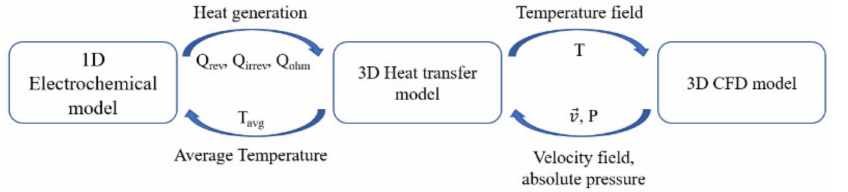
Figure 2. Schematic coupling of the electrochemical, heat transfer, and CFD (Computational Fluid Dynamics) modules.